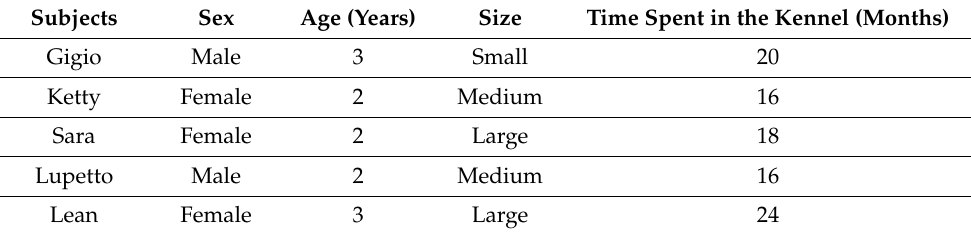
Table 1. Characteristics of dogs included in the Animal Assisted Interventions